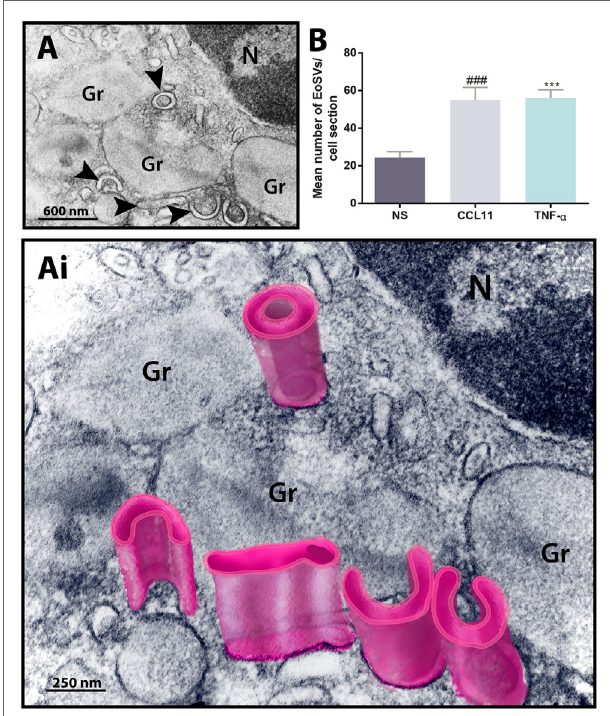
FigUre 2 | Ultrastructure of eosinophil sombrero vesicles (EoSVs). (a,ai) EoSVs are large tubular vesicles which are seen in cross-sectional appearance in electron micrographs as curved, elongated or folded circumferential structures [arrowheads in (a) and highlighted in pink in (ai) ]. EoSVs are derived from and interact with secretory granules (Gr). These vesicles are frequently observed around or in contact with granules in process of emptying (a,ai) , and their number increases in response to cell activation with stimuli such as CCL11 and tumor necrosis factor alpha (TNF- α ) (B) . Data represent mean ± SEM. Electron micrographs ( n = 30) from unstimulated and stimulated cells were evaluated, and the numbers of EoSVs ( n = 1,357) were counted in each cell section. NS, not stimulated. ### P = 0.0004 versus NS group; *** P = 0.0003 versus NS